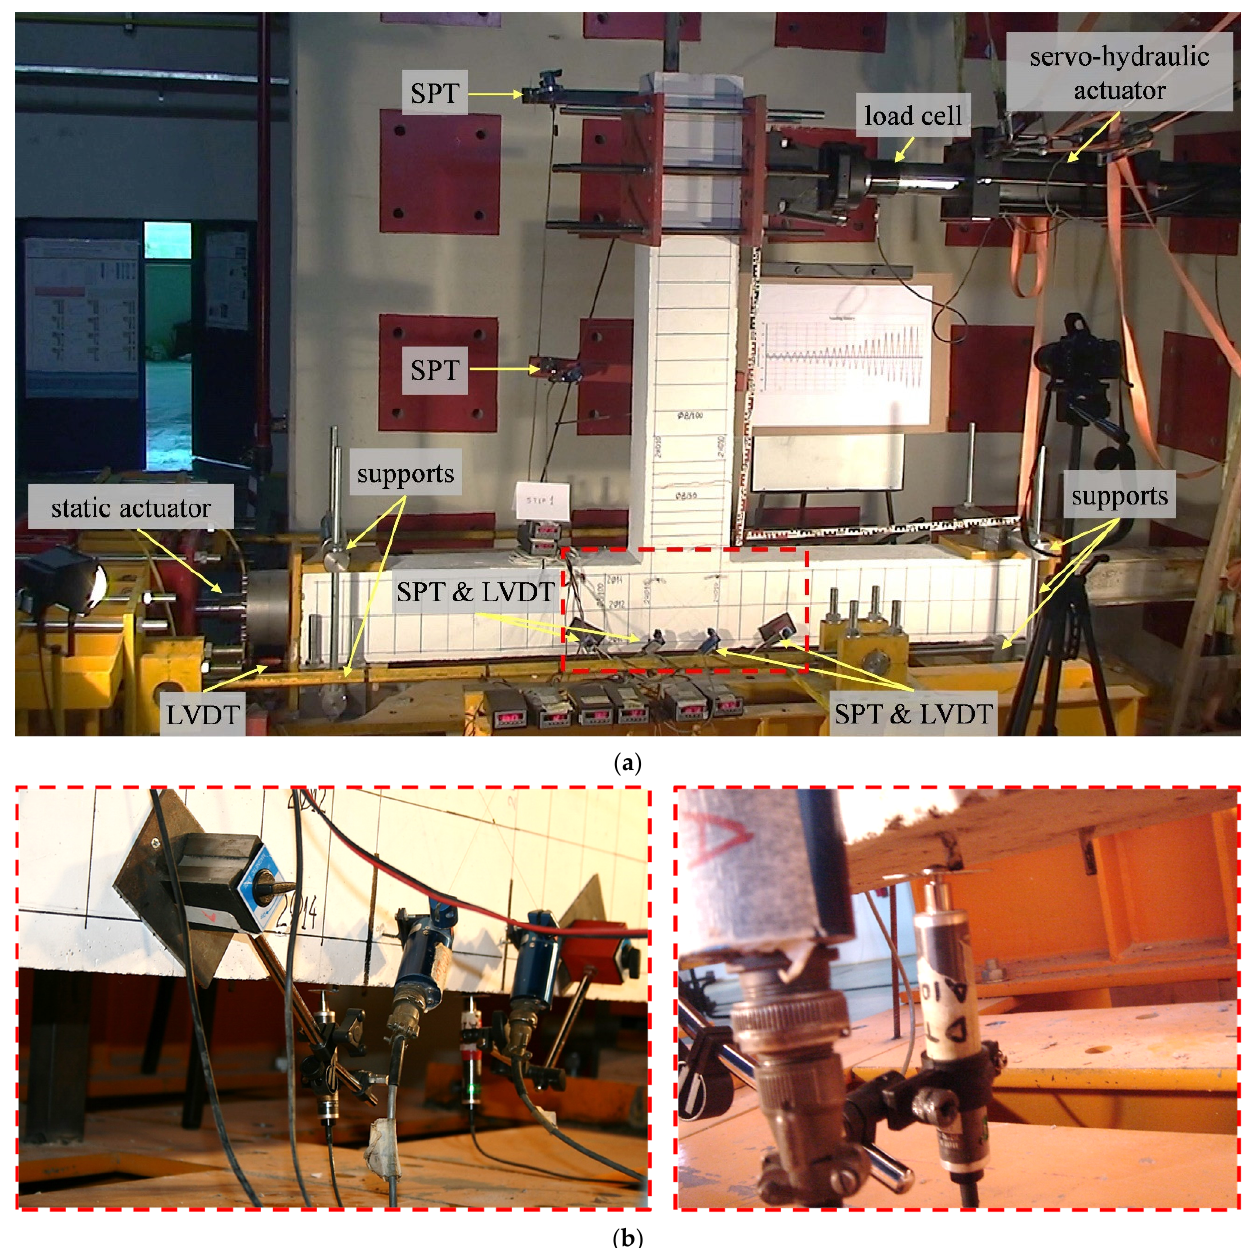
Figure 3. ( a ) Experimental setup and instrumentation of the full-scale beam-column joint specimens under lateral imposed cyclic reversal deformations; and ( b ) LVDT set for measuring the slip of the beams’ longitudinal CFRP bars (two LVDTs with 0.01 mm accuracy).